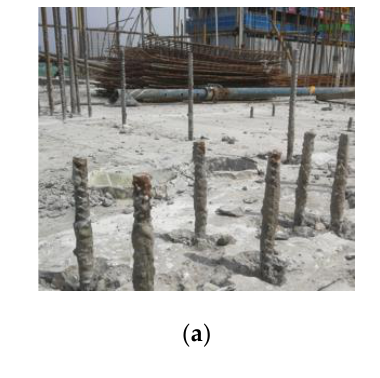
Figure 2. Types of partial defects in a grouted sleeve. ( a ) Foreign bodies bonded to rebars. ( b ) Insuf- ficient anchorage length of rebar. ( c ) Untimely grouting closure.